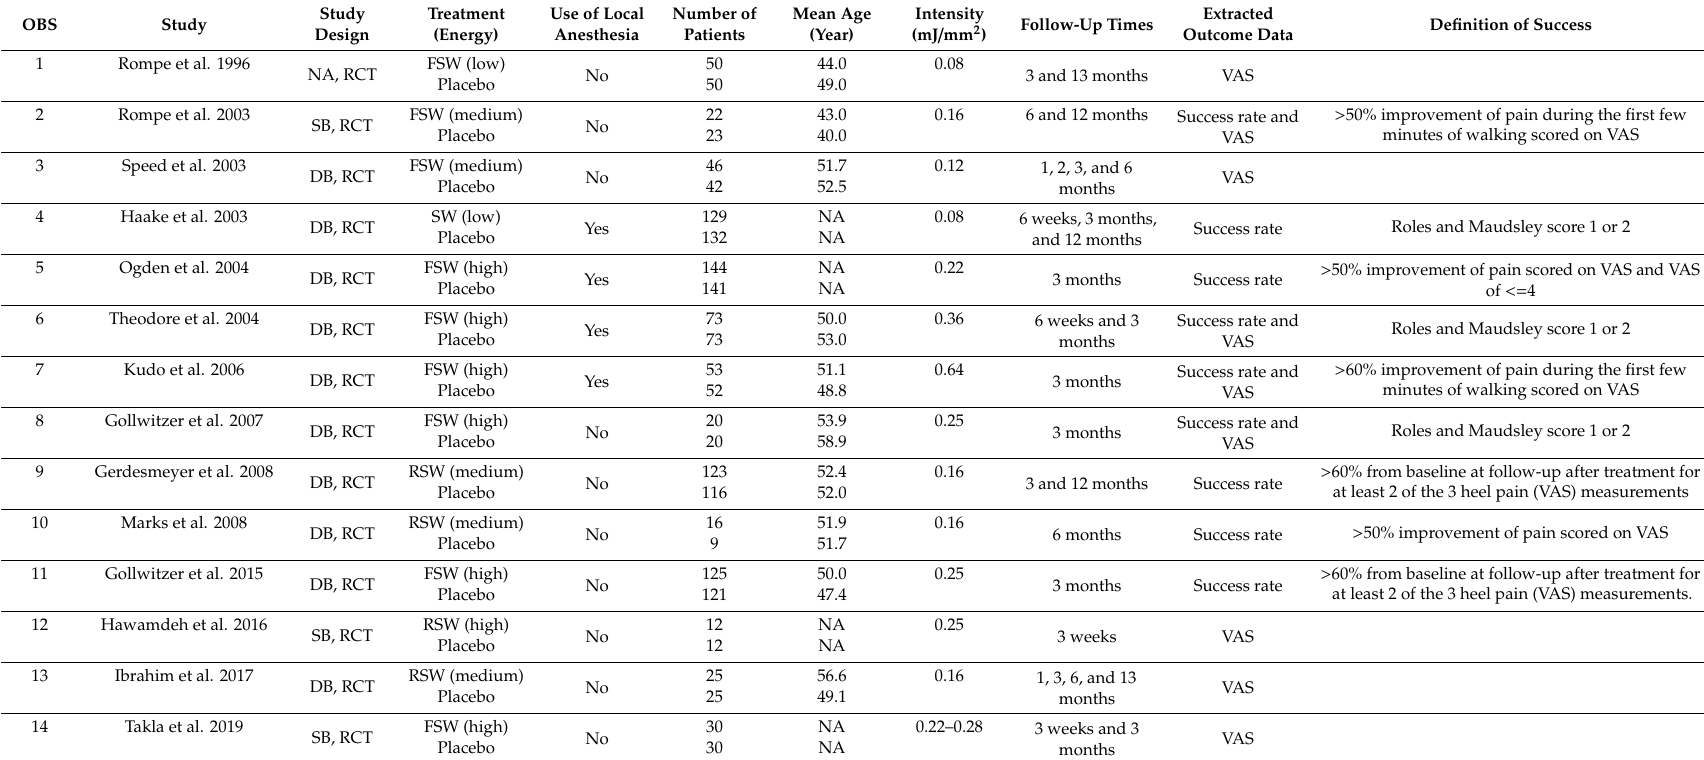
Table 1. Main characteristics of the 14 included